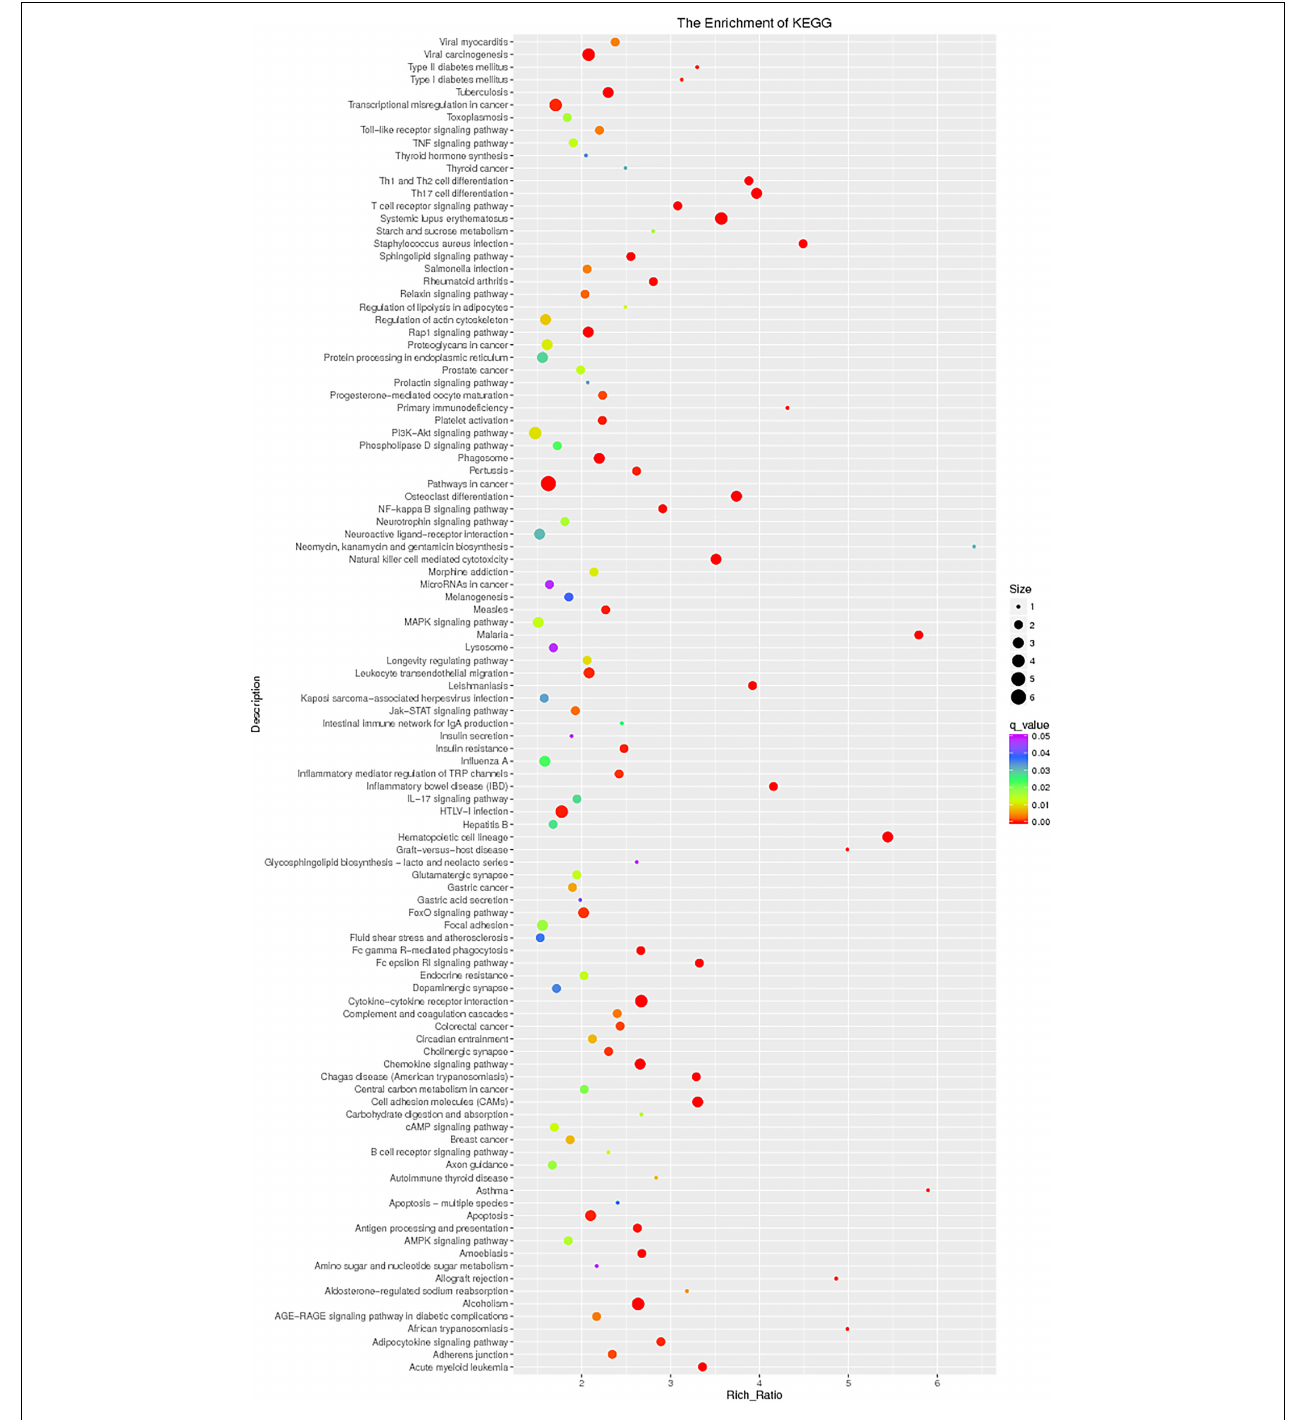
FIGURE 11 | KEGG pathway of